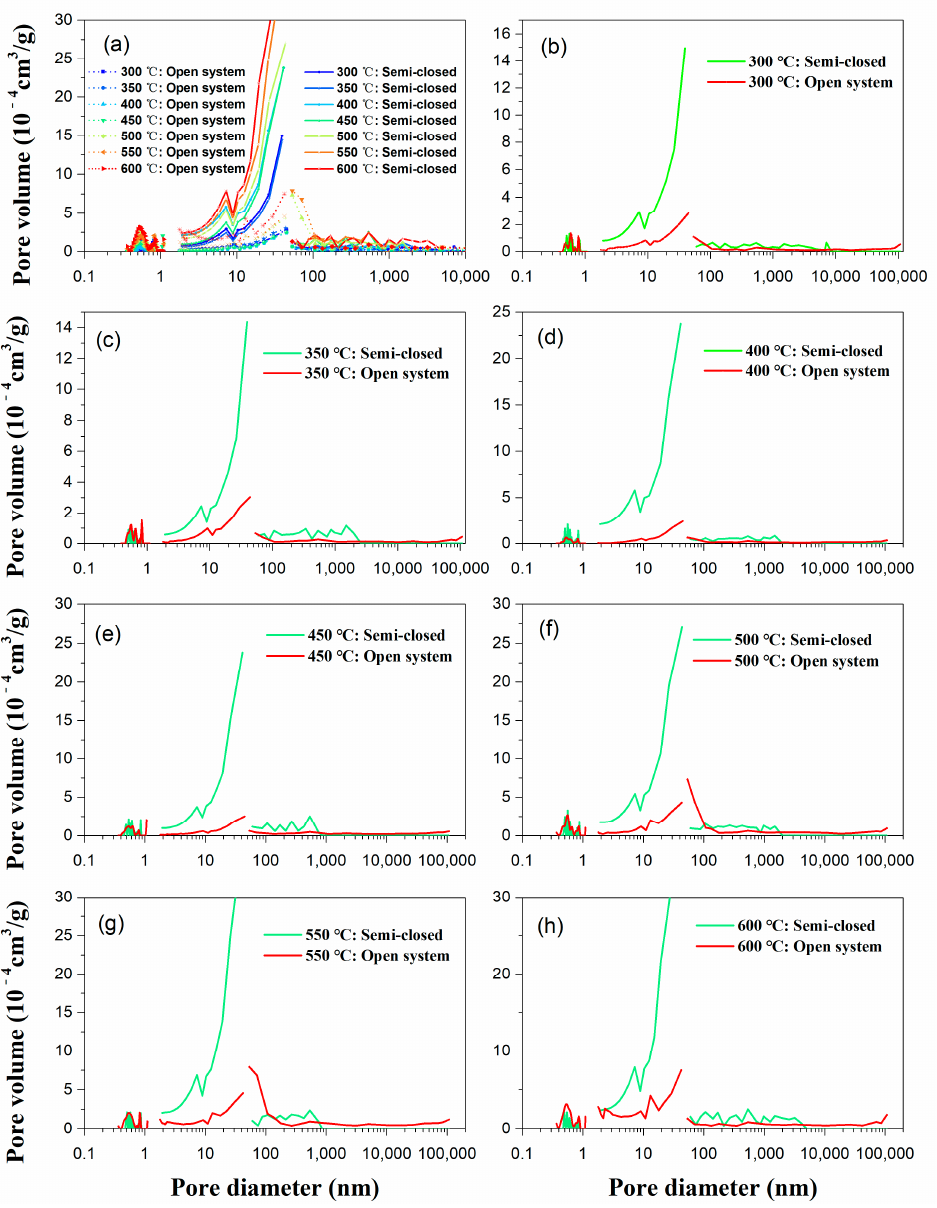
Figure 9. Full-scale pore size distribution based on open system and semi-closed system pyrolysis experiments by MIP, and CO 2 and N 2 physisorption. ( a ) Full-scale PSD of all samples; the dashed lines are data of open system pyrolysis, and the solid lines are semi-closed system pyrolysis. ( b – h ) Full-scale PSD of shale with temperature from 300 to 600 °C; the red curves are data of open system pyrolysis, the green curves are data of semi-closed system pyrolysis. Data of semi-closed pyrolysis are cited from Fang et al. [21].